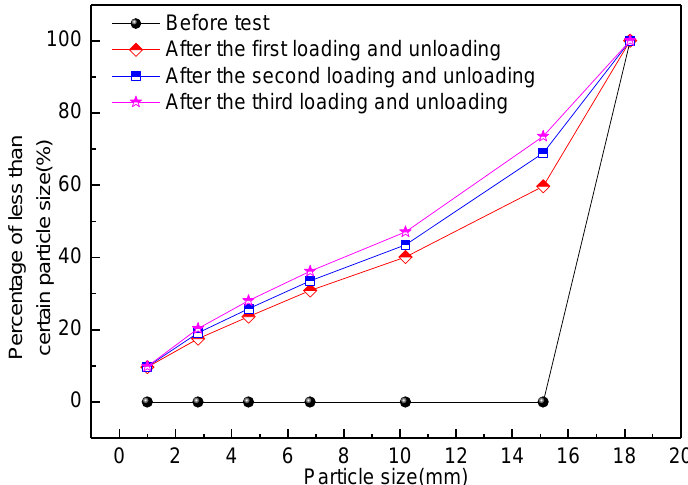
Figure 7. Size gradation curve before and after the seepage test of the broken coal sample.